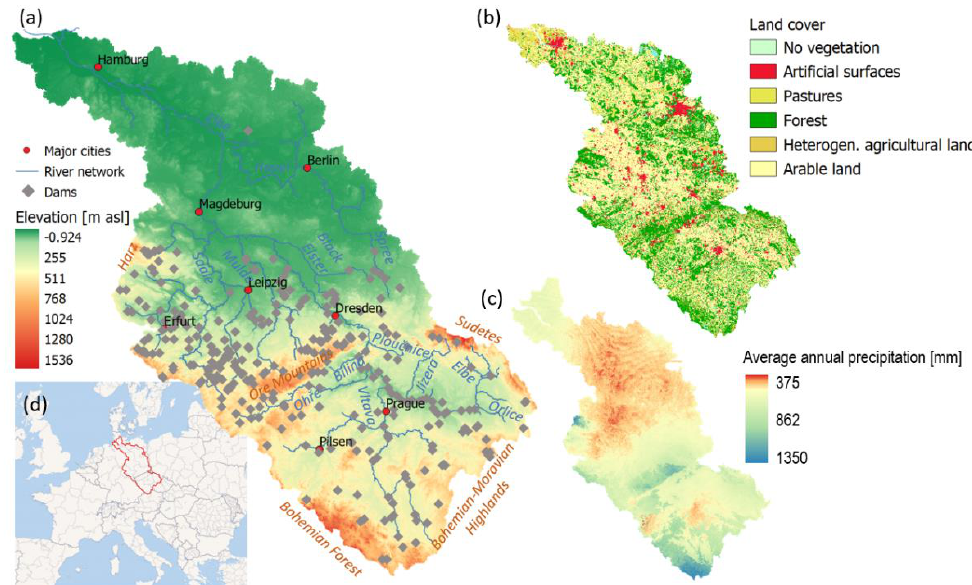
Figure 1. The Elbe basin. ( a ) Topography (source: EU-DEM, [45]), ( b ) land cover (reclassified from Corine Land Cover 1990 [46]), ( c ) average annual precipitation (DWD reference ensemble) and ( d ) location of the basin in Central Europe (source: Wikimedia Maps). Figure created by the authors. The basin is located in the temperate climate zone. Annual average temperatures range from 1–3 ◦ C at the higher altitudes of the low mountain ranges to 8–9 ◦ C in the lowlands [43]. Average annual precipitation ranges from 450 mm in the rain shadow of the